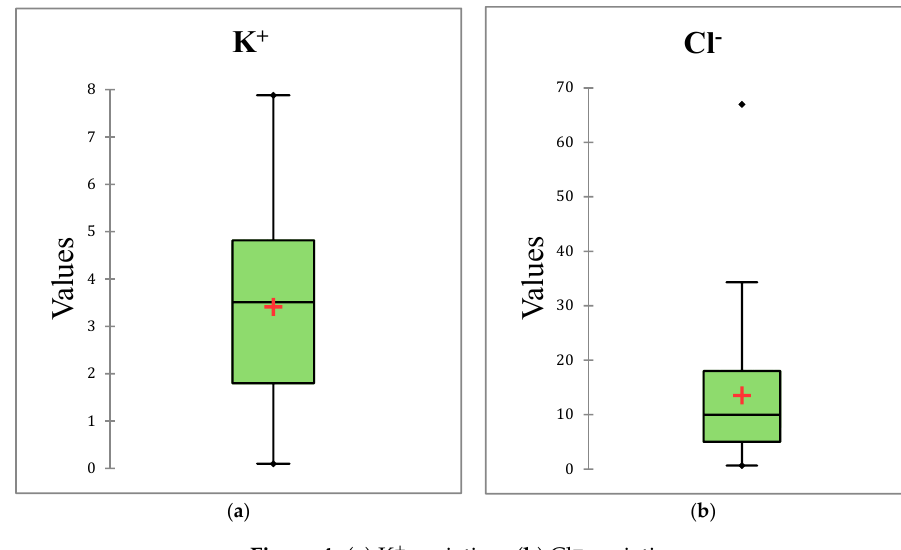
Figure 4. a ) K + variation. b ) Cl − variation. Figure 4. ( a ) K + variation. ( b ) Cl −